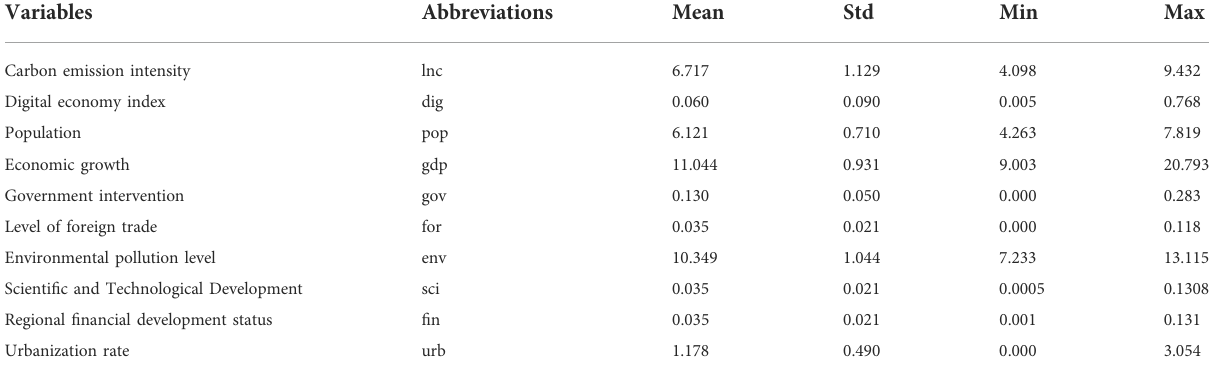
TABLE 2 Descriptive statistics of main variables.